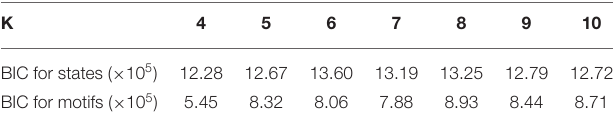
represent the proportions of correct inference levels. Figure 3A shows the number of predictions that are correct, the condition of no change has the highest probability of